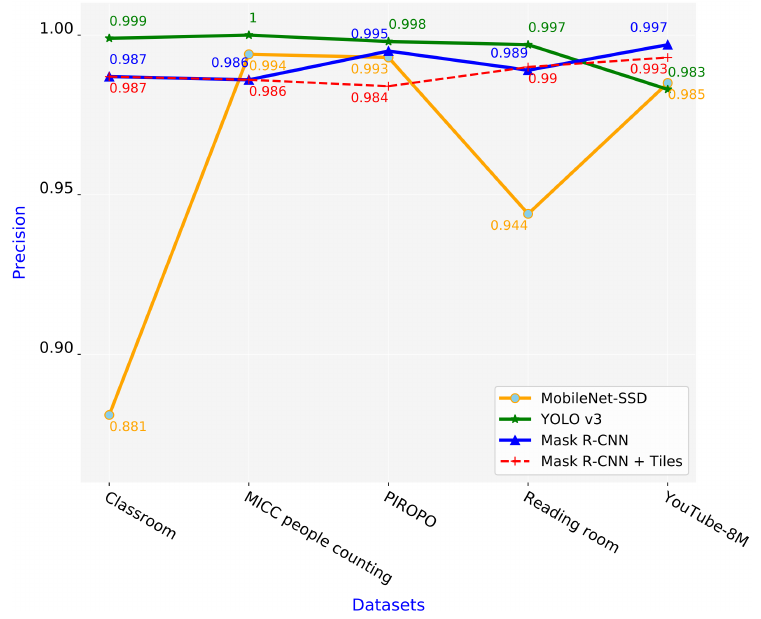
Figure 9. Precision values of four schemes.